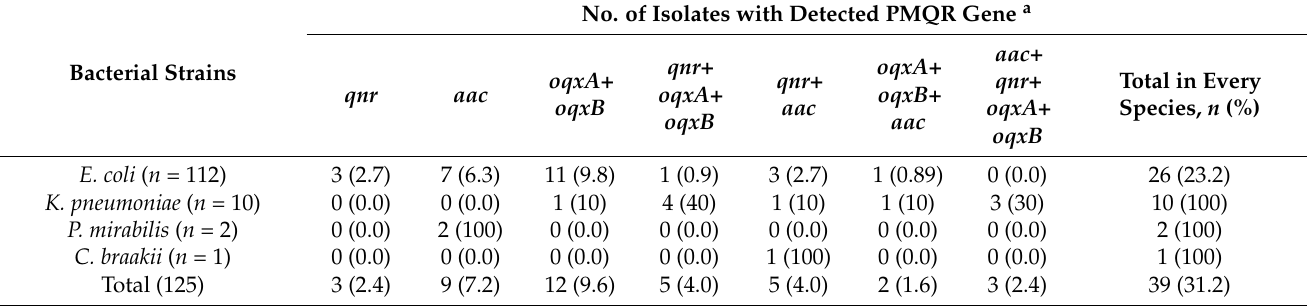
Table 1. PMQR gene combinations in 125 bacterial isolates.